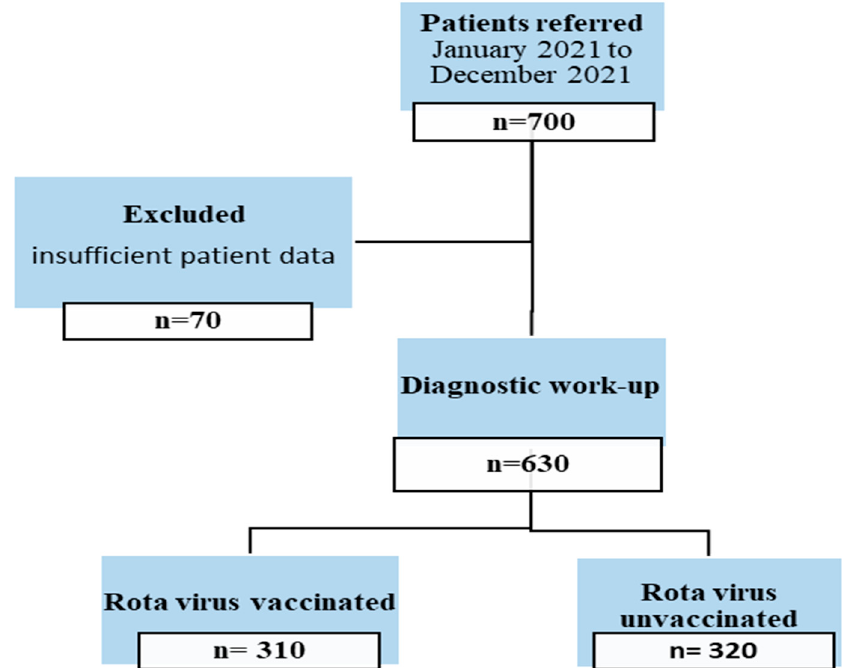
Figure 1. A flow chart of the selection of cases.